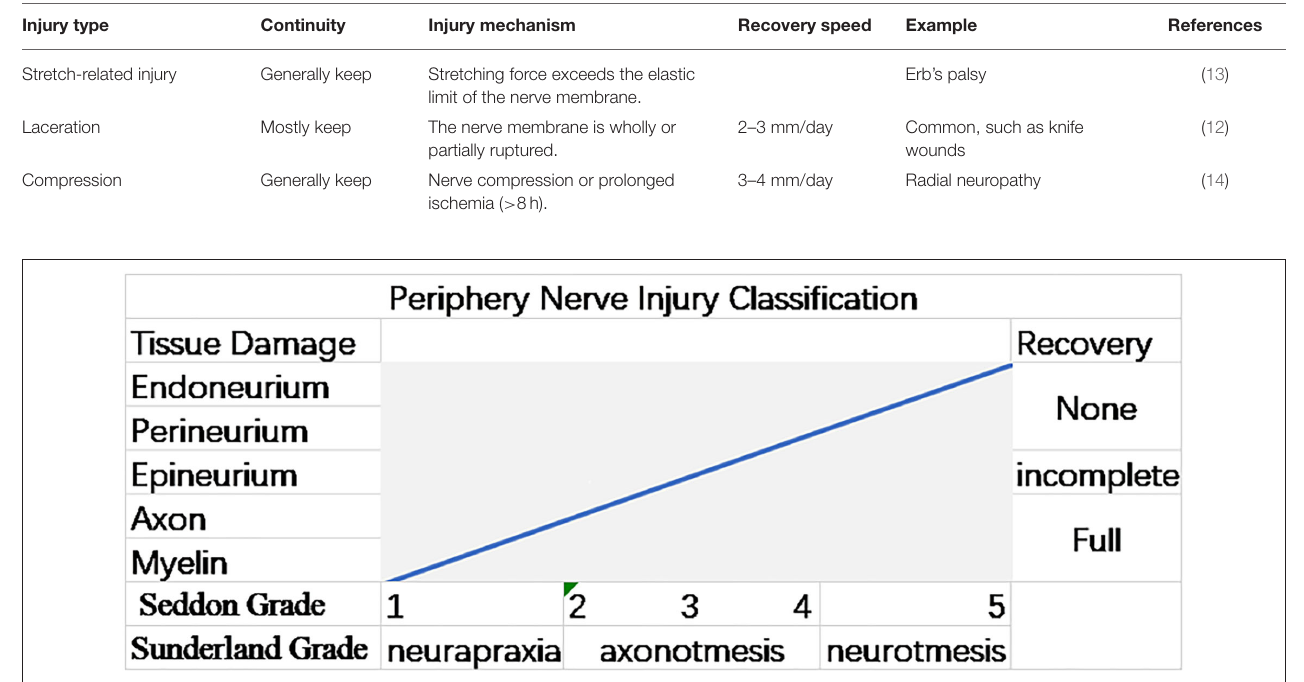
FIGURE 1 | Graph illustrating the Sunderland and Seddon peripheral nerve injury (PNI) grading systems. The gradations in both the systems are associated with the injury’s anatomical extent and the chance of a spontaneous